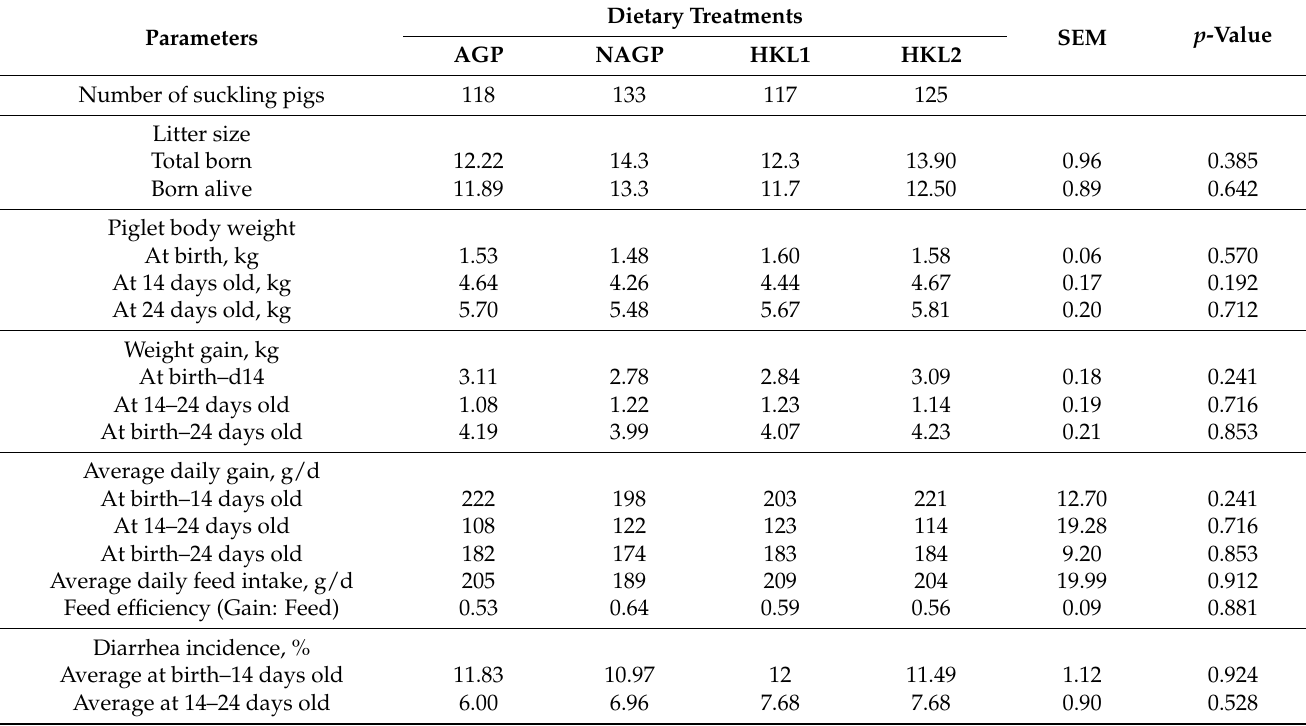
Table 3. Effects of the dietary treatments on the growth performances of piglets fed on the experi- mental diets from 14 days of age until weaned (24 days